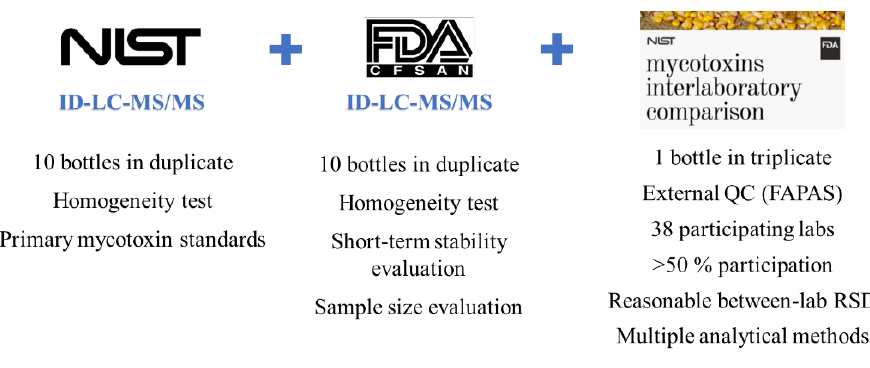
Figure 2. Development of SRM 1565.